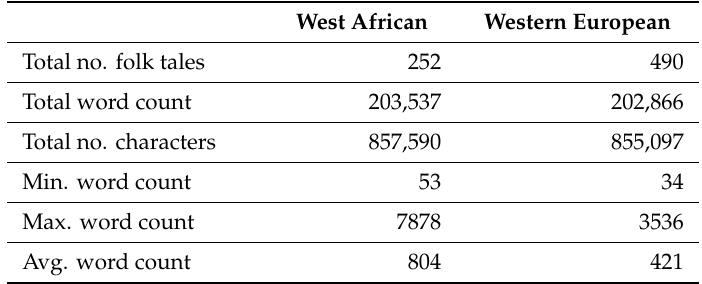
Table 1. Descriptive statistics for the two corpora of type